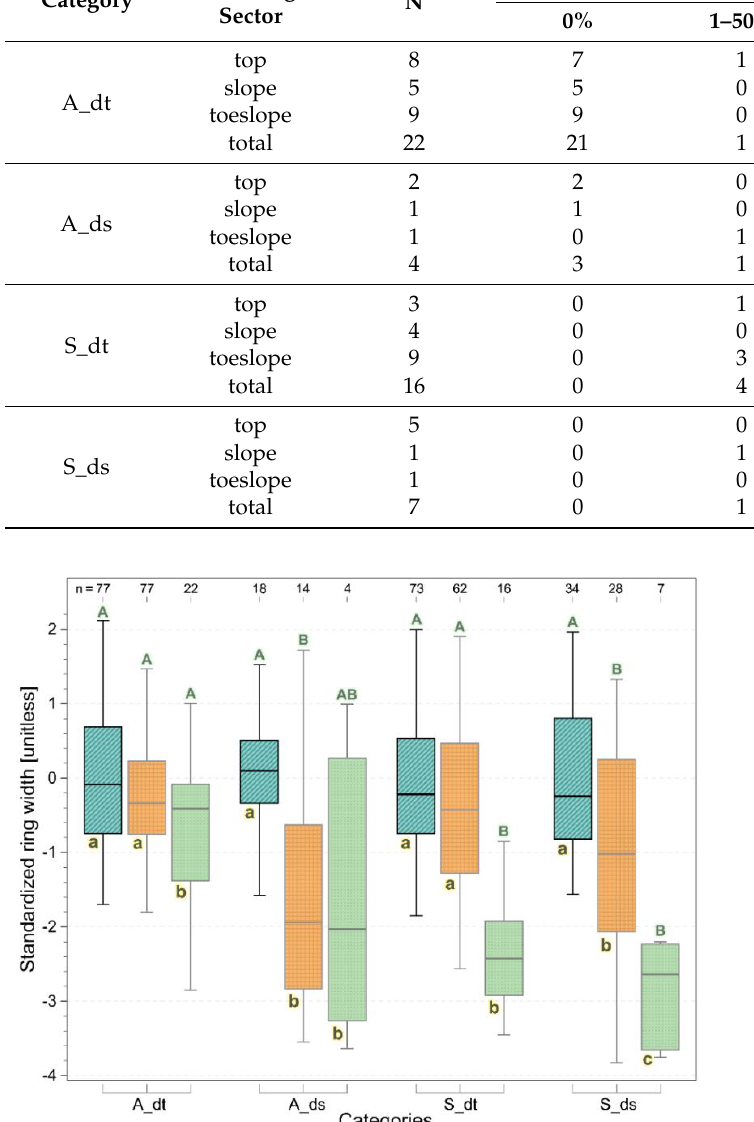
Table 3. Number of samples with phloem anomalies according to the four main categories of asymp- During the season of external symptom expression (i.e., 2019), symptomatic speci- tomatic drought-tolerant (A_dt), asymptomatic drought-sensitive (A_ds), symptomatic drought- tolerant (S_dt), and symptomatic drought-sensitive (S_ds) and the growing sector along the slope (top, slope, and toeslope). N: number of analysed samples per category and sector. Samples with Phloem Anomalies in 2019 Growing Category N Sector